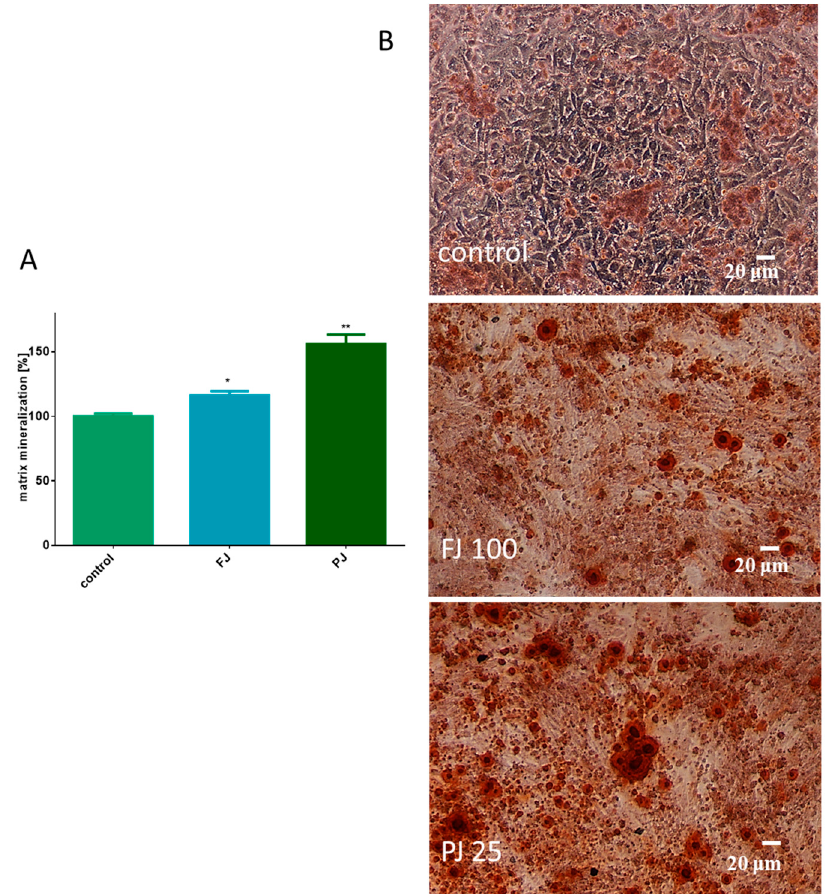
Figure 5. The influence of V. opulus FJ and PJ at IC 0 dosage on Saos-2 cell matrix mineralization, determined by alizarin red S assay after 8 days of exposure ( A ); control cells were not exposed to any compound; values are means ± SEM, n ≥ 12; statistical significance was calculated versus control cells (untreated), * p ≥ 0.05, ** p ≥ 0.01. Cells stained with alizarin red S after their incubation with 100 μ g/mL FJ and 25 μ g/mL PJ ( B ); randomly chosen fields were photographed at ×200 with contrast-phase microscope.